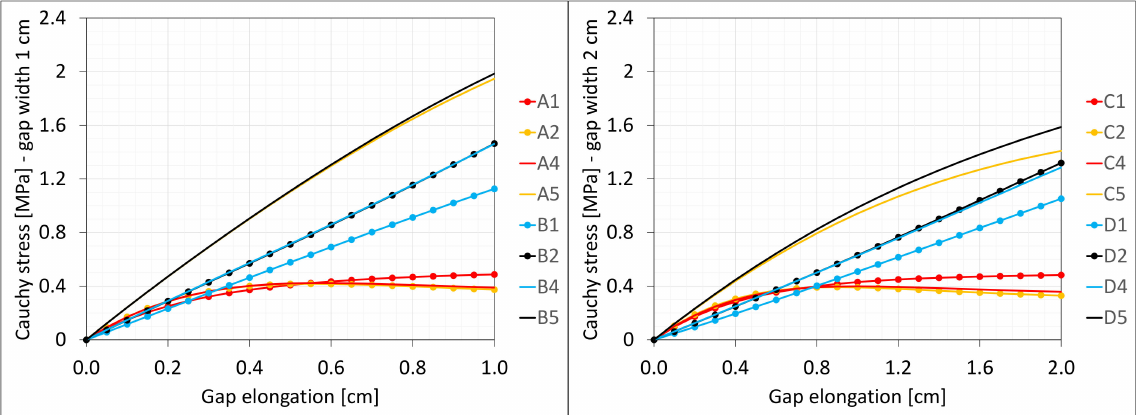
Figure 3. Equilibrium paths for stresses σ _z in selected nodes. The width of the gap is equal to 1.0 cm, left graphic, and 2.0 cm, right.